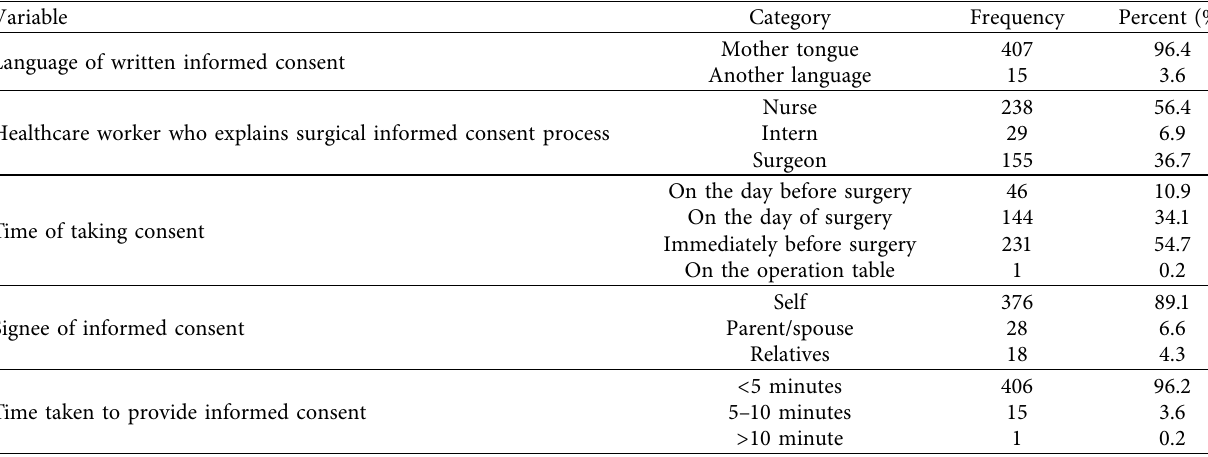
Table 3: Service-related characteristics of surgical patients in Dessie City Administration public hospitals, Northeast Ethiopia, 2021 ( N � 422).